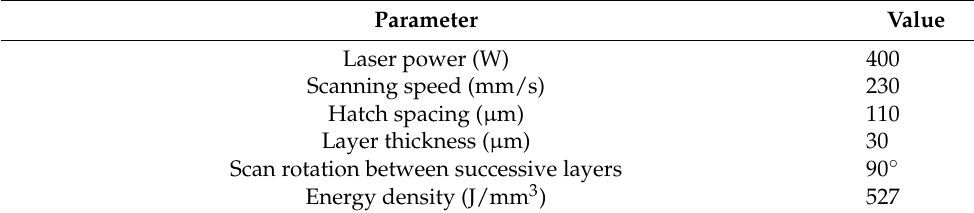
Table 2. SLM processing parameters used to manufacture the 316L SS samples.